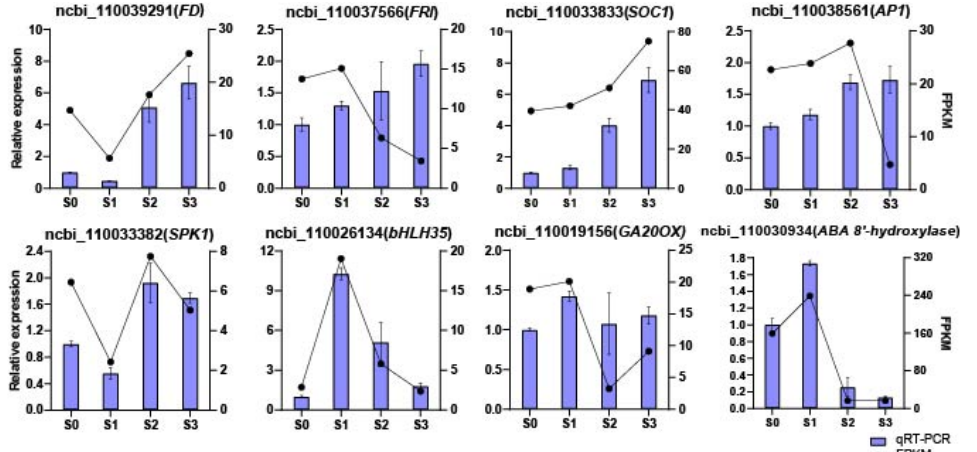
Figure 8. qRT-PCR validation of the expression patterns of 8 differentially expressed genes (DEGs) during spike development. The x -axis represents the four statuses; the left y -axis represents the relative expression levels normalized from the qRT-PCR results; the right y -axis represents the FPKM values from RNA-seq. Error bars are the standard deviation (SD) of the mean ( n = 3).